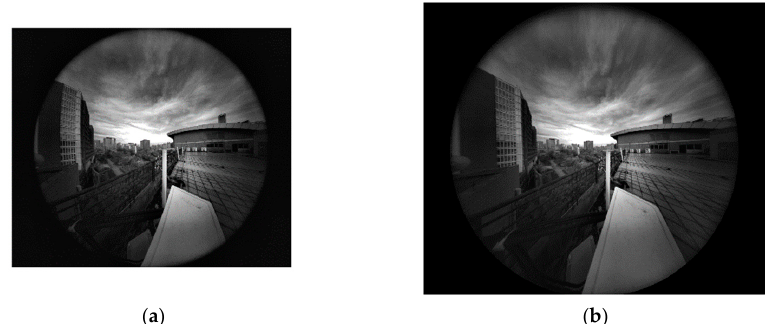
Figure 19. Experimental results of the outdoor scene. ( a ) Distorted image of size 2048 × 2448 pixels; ( b ) Corrected image of size 2496 × 2984